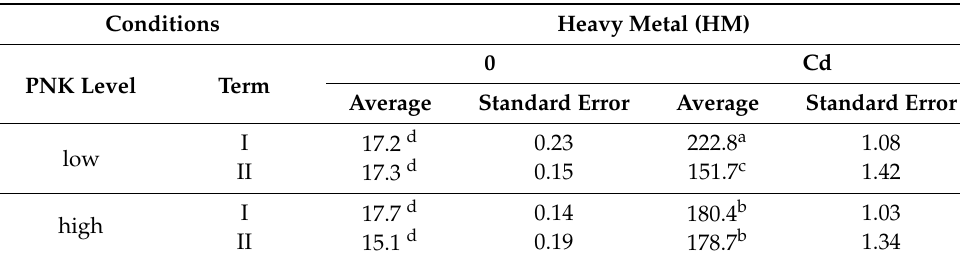
Table 4. The accumulation of cadmium n Hydrocharis morsus-ranae (µg Cd) in the three tested growing seasons.